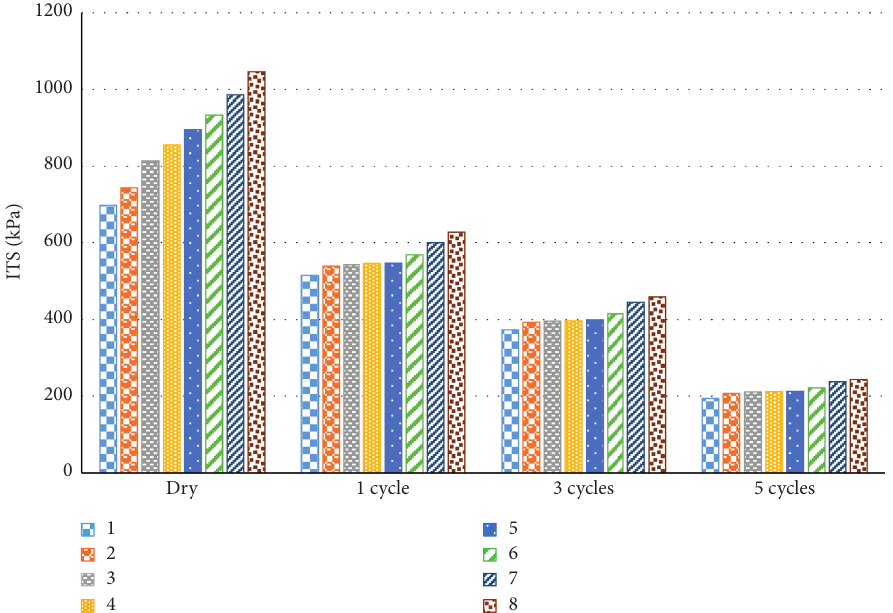
Figure 5: ITST results in samples made with various forming minerals in different F-T cycles.